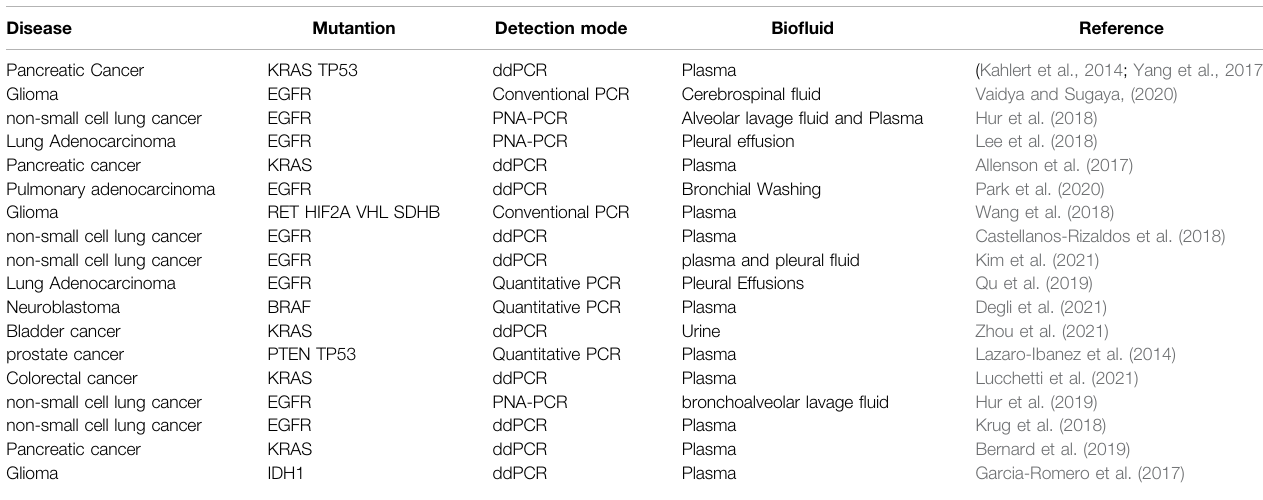
TABLE 1 | Exosome gDNA as biomarkers for diagnosis of diseases.